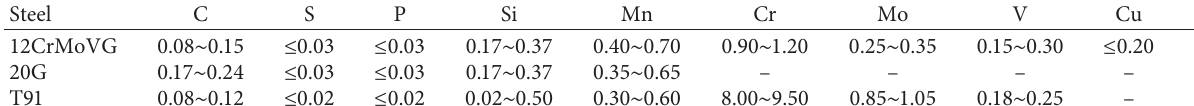
Table 3: Elemental composition of the heating surface metal (%).